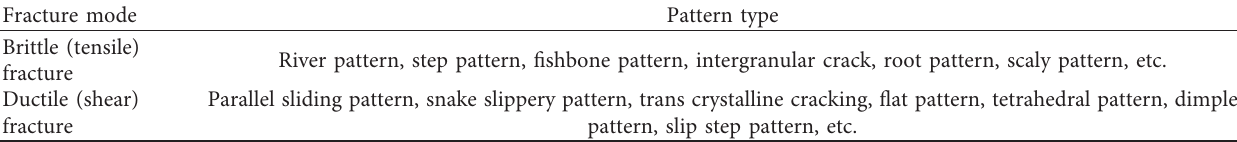
Table 4: Typical fracture morphology of rock